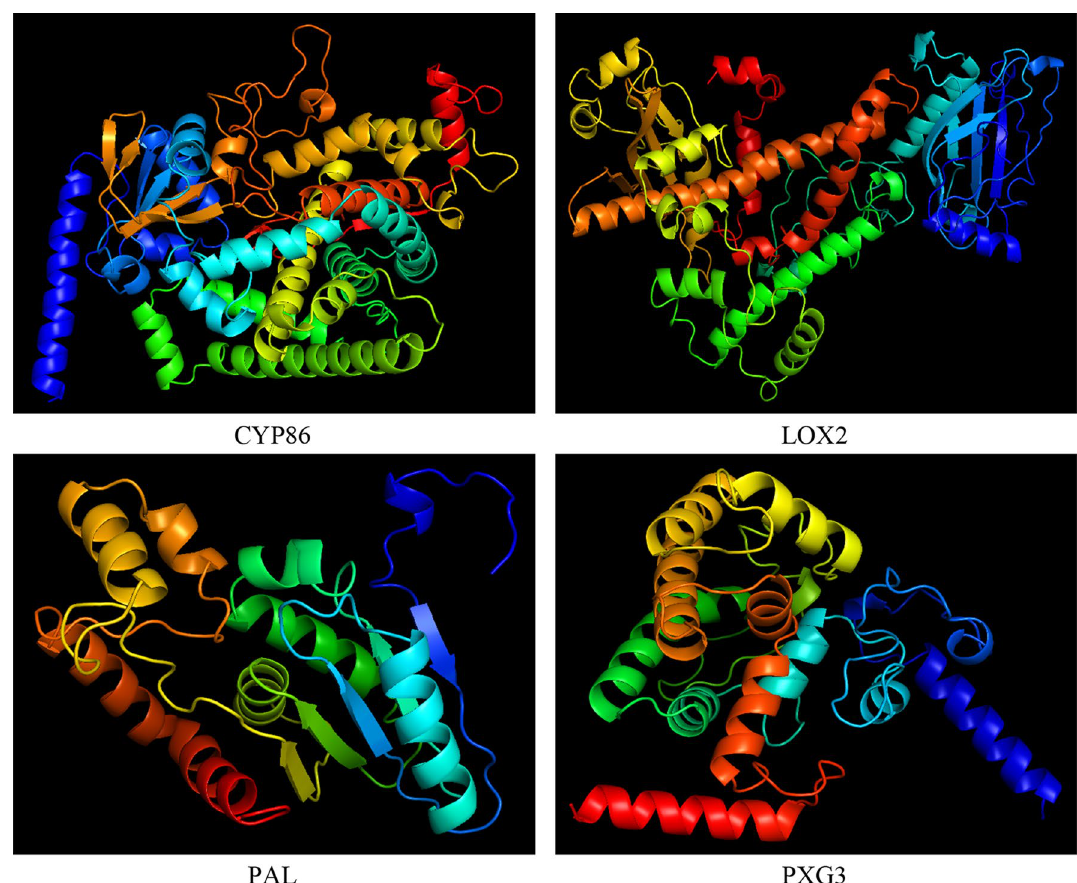
Figure 7. Modeled structures of the selected four proteins with cartoon representation in milk thistle. Proteins are colored by spectrum from N to C terminus. The confidence (TM-score) of the predicted models in CYP86, LOX2, PAL and PXG3 are high (0.544), low (0.325), high (0.518) and medium (0.467), respectively.